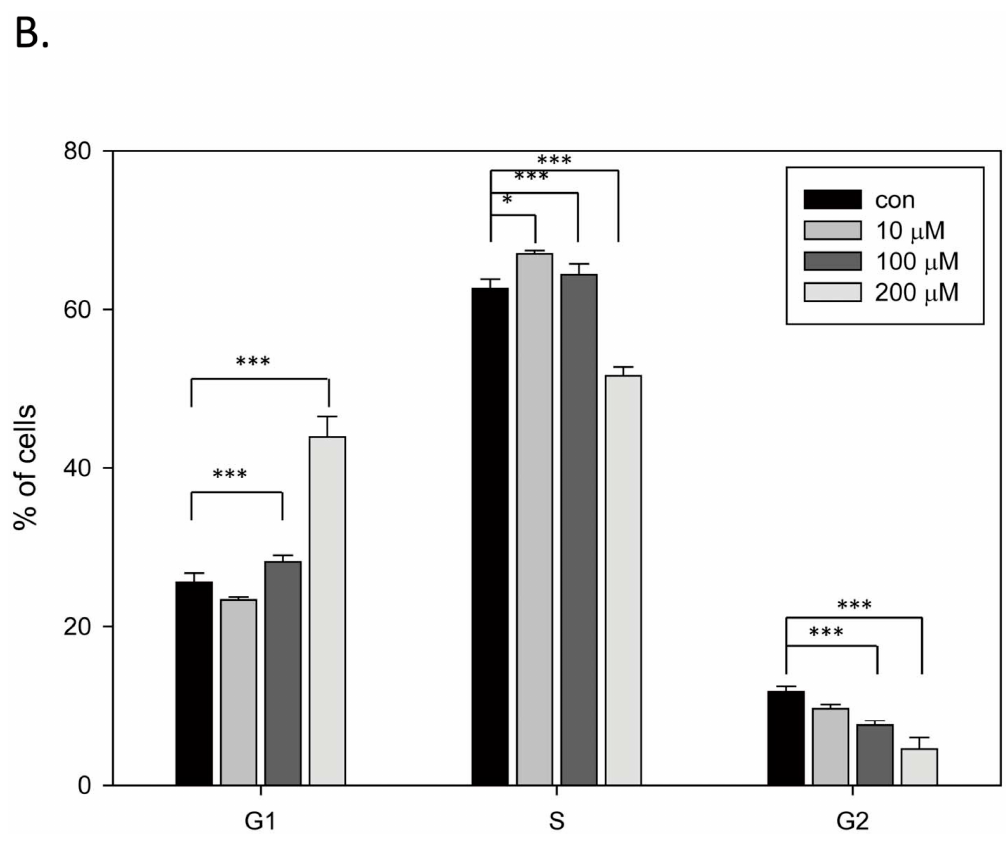
Figure 3. Capsaicin induces cell cycle arrest. TSGH cells were treated with capsaicin or ethanol for 18 h. ( A ) Aliquots of cell lysates were separated by SDS-PAGE and analyzed by western blotting. β -actin was used as an internal control. The intensity of a protein band was quantified by Gel-Pro Analyzer software 3.1. The resultant values of protein expression were normalized to those of actin. Values (mean ˘ SE) are from three independent experiments (*** p <0.001); ( B ) Cells were assayed for cell cycle phase. The graphs are representative of three independent experiments. Values (mean ˘ SE) are from three independent experiments. The percentage of cells in G1 phase was significantly higher in cells treated with 100 and 200 µ M capsaicin compared to cells in the control group by one-way ANOVA with LSD (* p < 0.05, *** p <